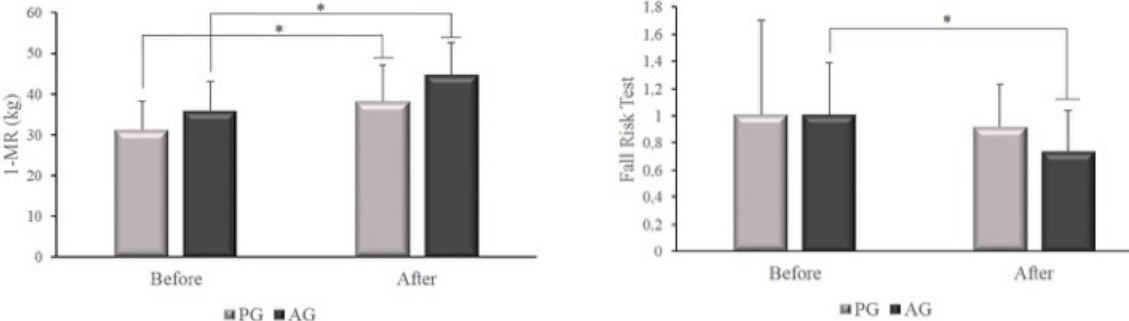
Figure 4 - Values as means and standard deviations of Fall Risk Test.